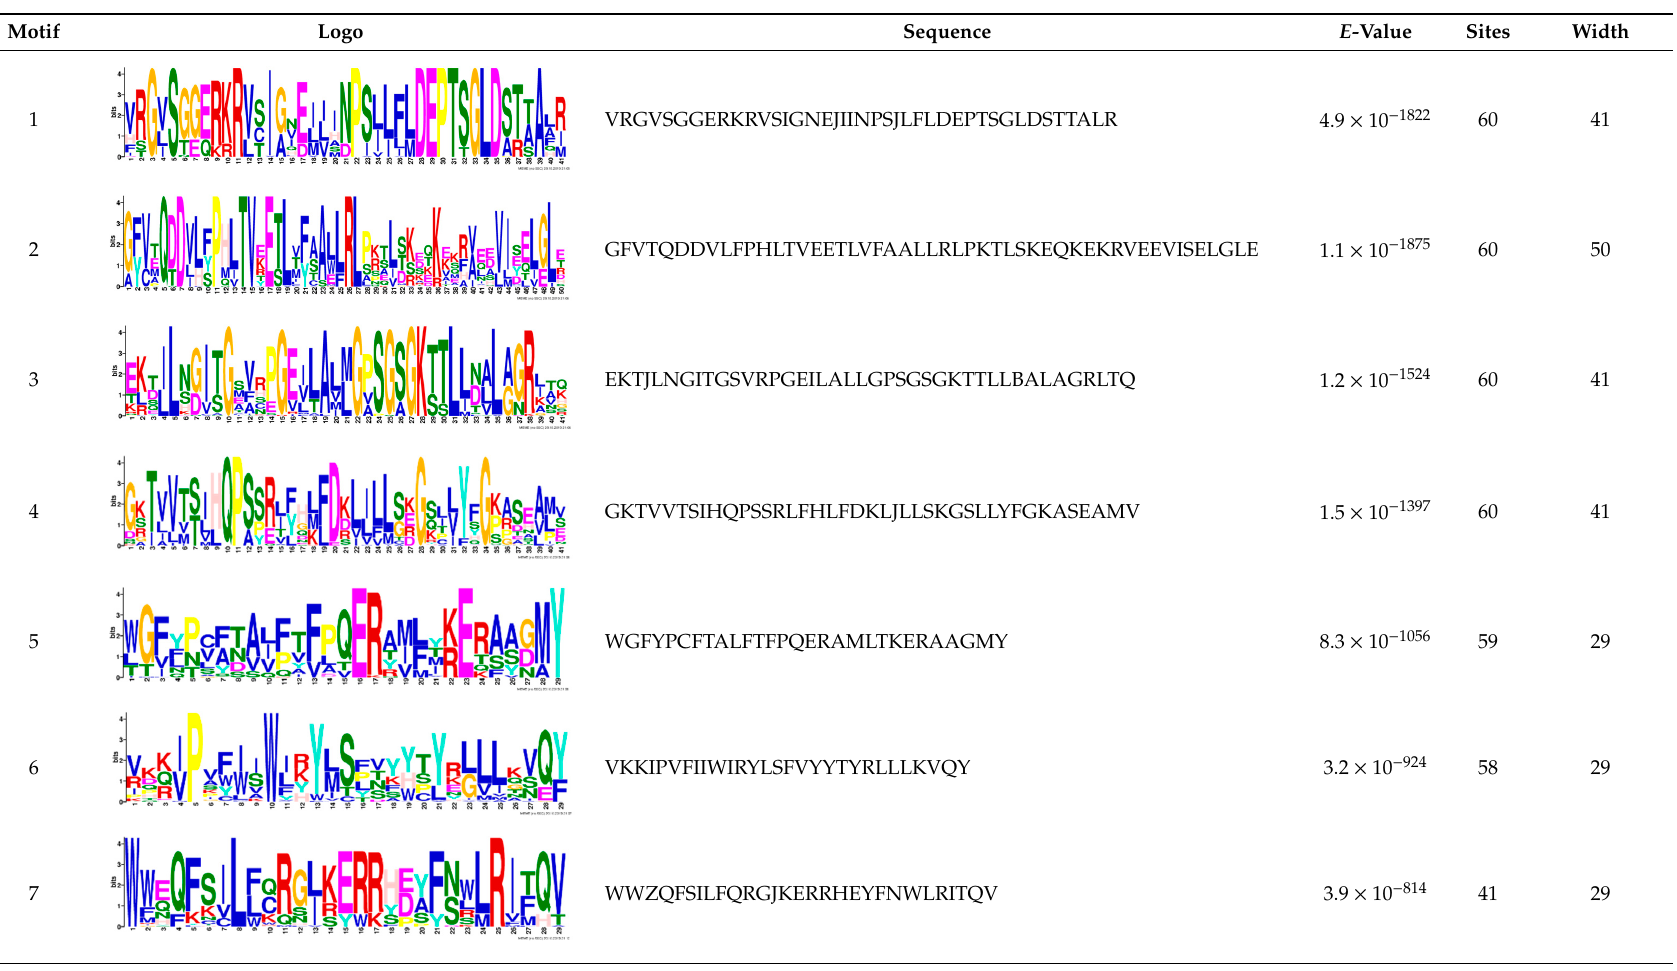
Table 1. Motifs information of potential phytohormone transporters in ABCG subfamily genes of nine Rosaceae species.